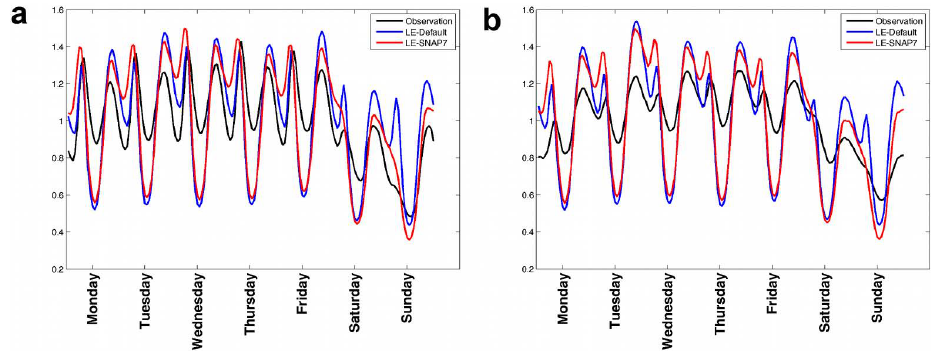
Fig. 6. Simulated and measured normalized weekly cycle of NO 2 at all available urban (a) and rural (b) stations. Marks along the top show